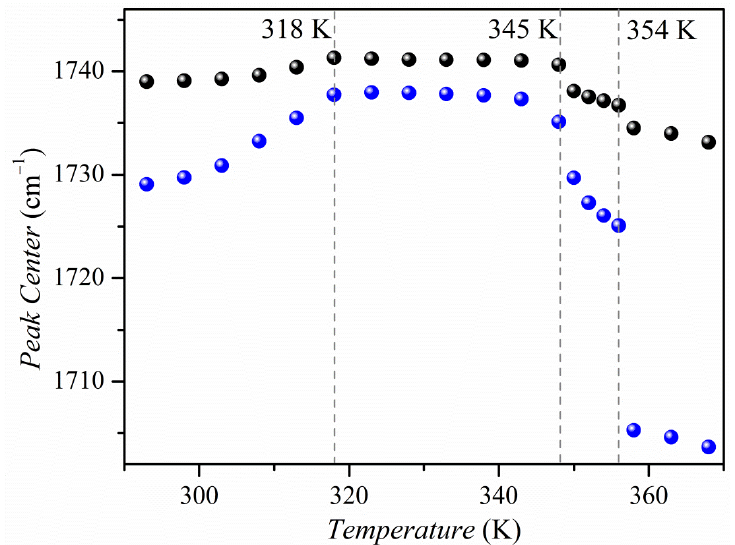
Figure 12. Temperature evolution of the position of the carbonyl bands 1737 (black spheres) and 1728 cm − 1 (blue spheres).